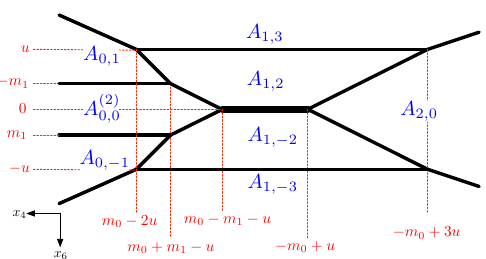
in Figure 24. The regions for the largest A ( m ) k;l Region 4 of the E 2 theory.